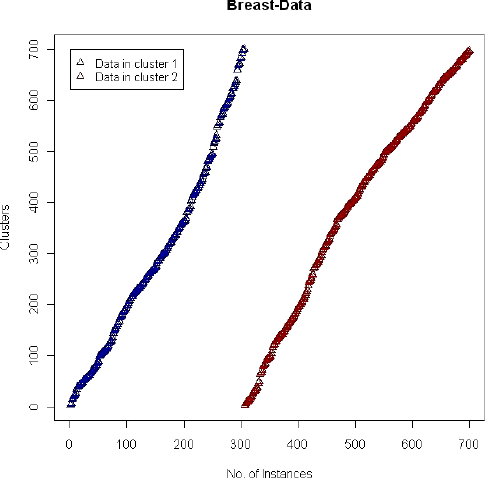
Fig. 24. Size of clusters by KFCM.